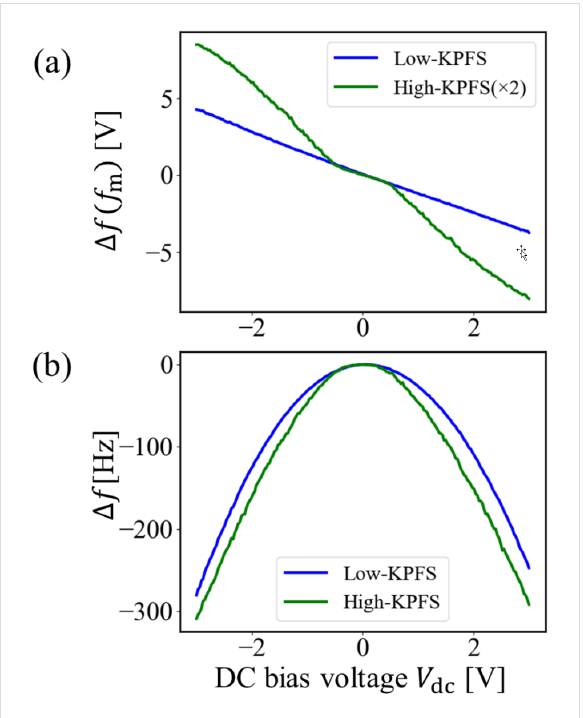
Figure 7: (a) Δ f ( f m )– V dc curves and (b) Δ f – V dc curves obtained on the n-type Si surface. The tip–sample distance was set with Δ f set = − 300 Hz ( z to ≈ 15 nm) when V dc = 3 V and V ac = 0.5 V were applied between the tip and the